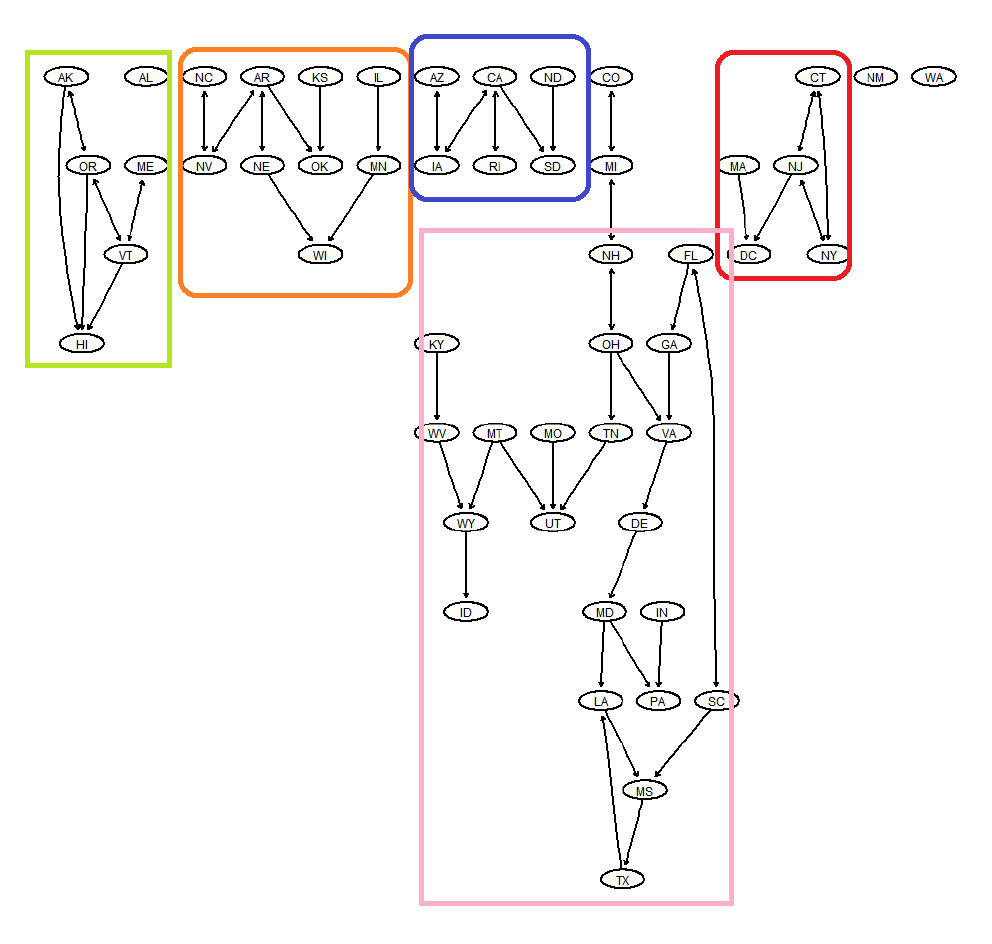
Figure 2. Estimated CPDAG with COVID-19 daily cumulative mortality data from 50 states and Washington, D.C. (22 January 2020 to 1 September